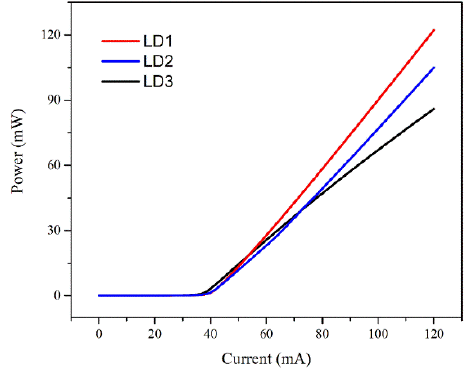
Figure 7. Effective LQB height for electrons (black) and IL (blue) for various acceptor doping concentrations.